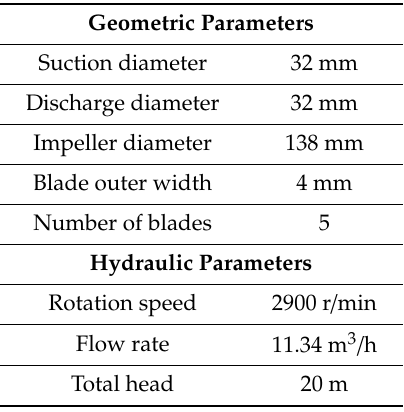
Table 1. Specifications for the experimental